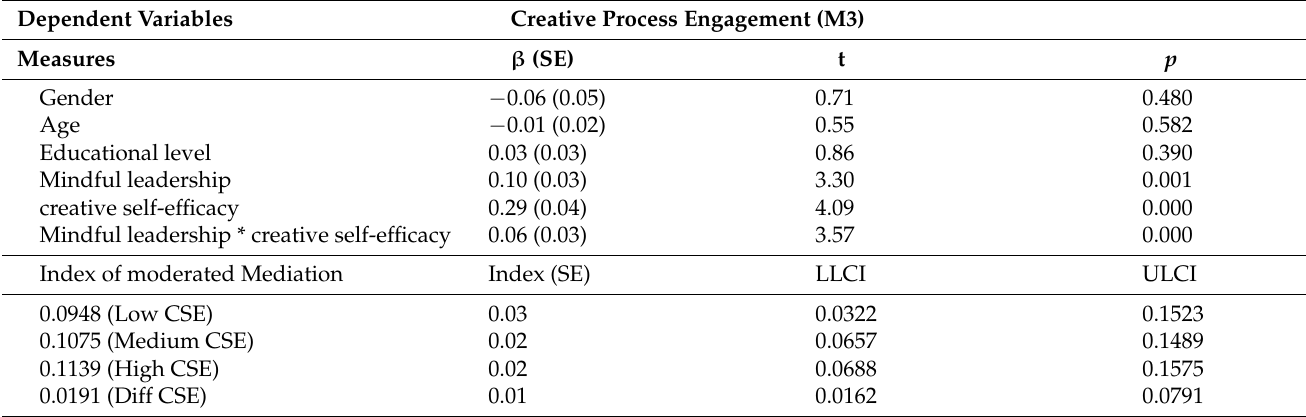
Table 4. Hierarchical regression results of the moderating and moderated mediation